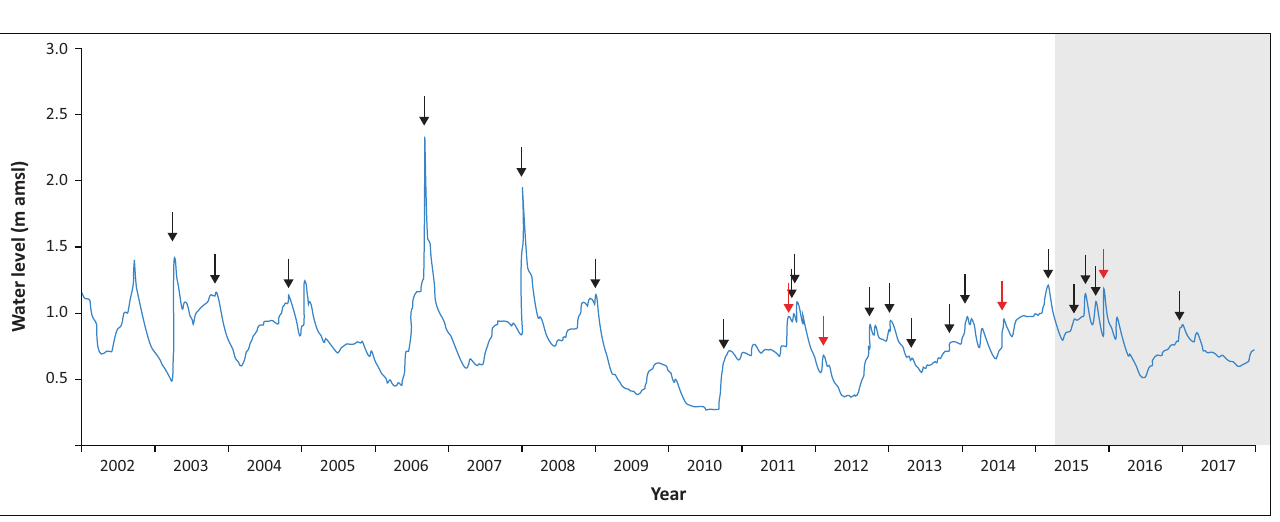
2017: January–May 2017.